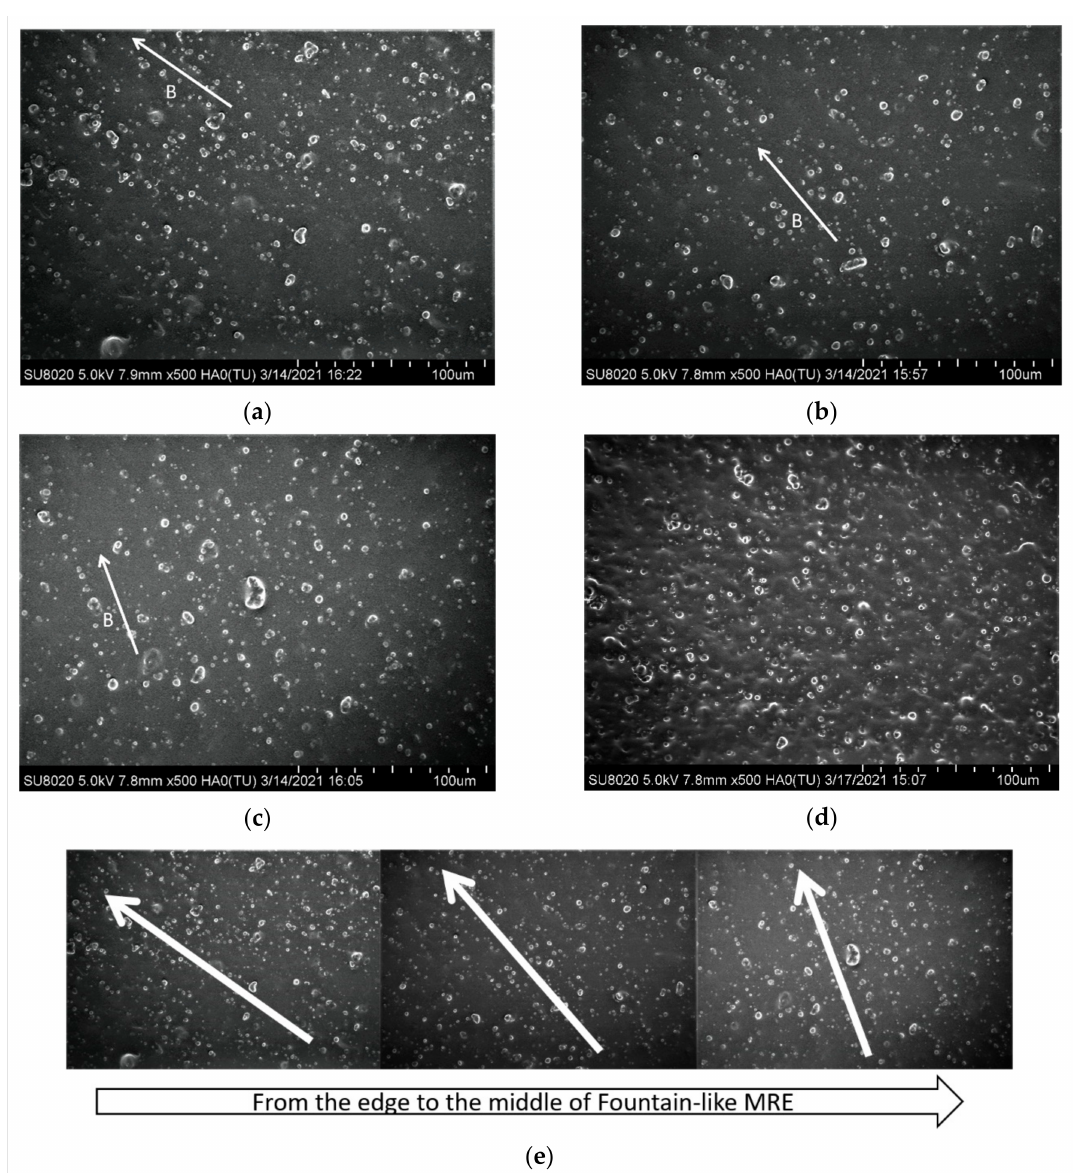
Figure 12. Morphologies of fountain-like MRE corresponded to ( a ) region A, ( b ) region B, ( c ) region C and ( d ) isotropic MRE. ( e ) shows the combined FESEM images from regions A, B and C. The direction of the magnetic field is shown by a white arrow and is labelled as